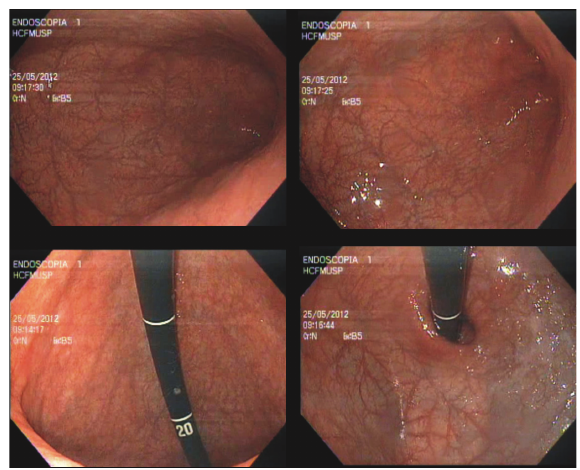
Figure 3: Gastric endoscopic aspects two months after treatment.